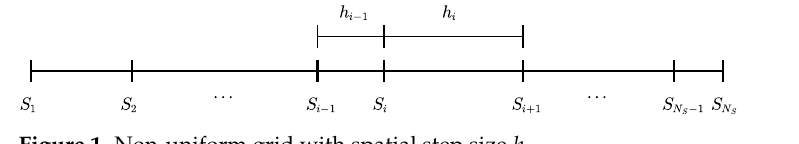
Figure 1. Non-uniform grid with spatial step size h i